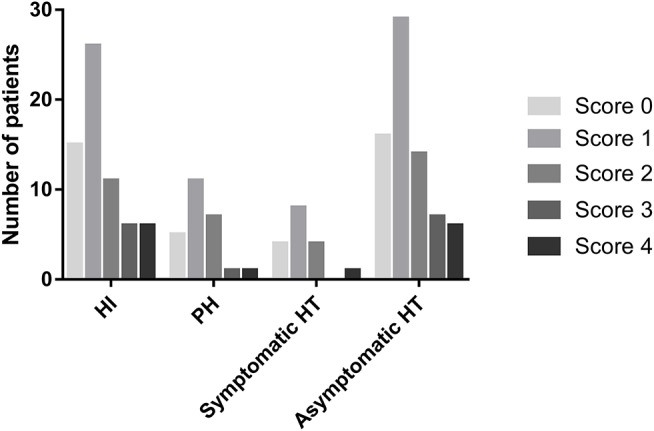
Numbers of patients presenting with different cerebral SVD scores, categorized by the subtypes of HT.